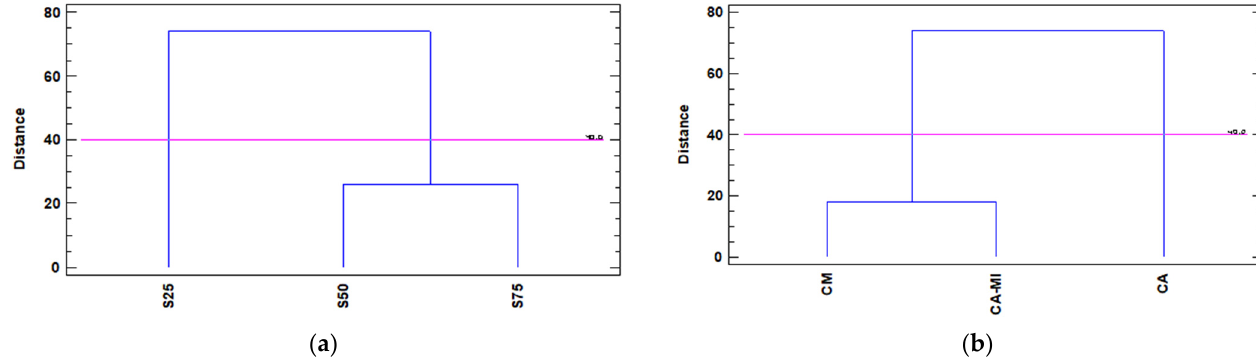
Figure 3. Dendrogram for the cultivation of ‘Verna’ lemons using Ward’s method based on the squared Euclidean distance of the morphological and chemical parameters, depending on the type of ( a ) cultivation substrate, where S25, S50, and S75 represent the content in the marine sediment substrate—being 25%, 50%, and 75%, respectively; and ( b ) rootstocks used, where CM, CA-MI and CA correspond to the Citrus macrophylla rootstocks Citrus aurantium/Citrus sinensis , and Citrus aurantium , respectively.